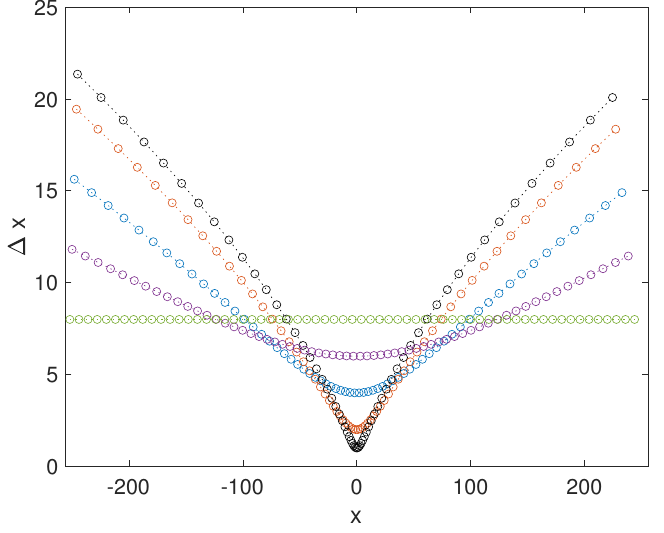
Figure 1. The step sizes from (3) as a function of x . The horizontal equi-spaced case is a = 0. The step size becomes increasing variable as a ascends through the samples a = 1,2,3, and 3.5 (the extreme graph). The step size near the origin vanishes as a → 4. The domain has length L = 512, with N = 64